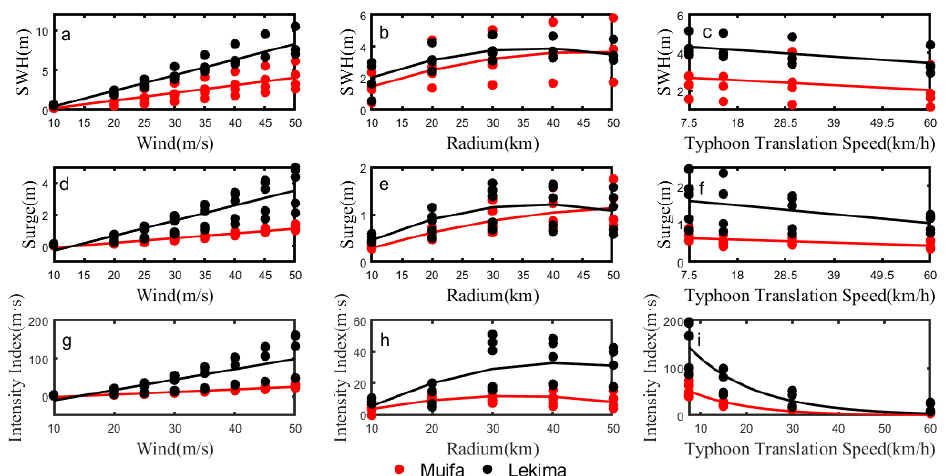
Figure 21. Fitted curve between the maximum significant wave height and ( a ) maximum wind speed; ( b ) radius of the maximum wind speed; ( c ) typhoon translation speed, maximum storm surge, and ( d ) maximum wind speed; ( e ) radius of the maximum wind speed; ( f ) typhoon translation speed; the Intensity Index of the maximum storm surge; and the ( g ) maximum wind speed, ( h ) radius of maximum wind speed, and ( i ) typhoon translation